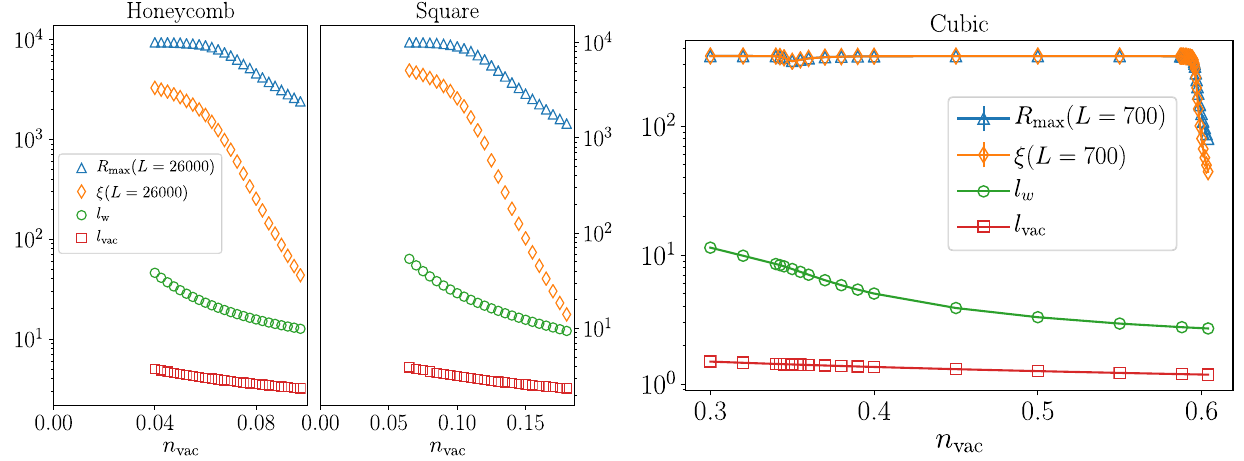
¼ 1 =n 1 =d l ¼ 1 =w 1 =d (where d is the spatial w vac , the mean distance between zero modes, vac , the sample-averaged max . Note that ξ and R track vac max limit, being limited only by the system size L in vac